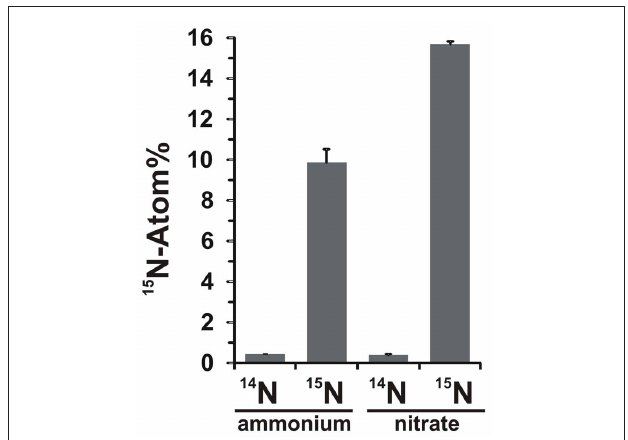
FIGURE 4 | Nitrogen uptake into N. profundicola biomass determined following one round of batch culture with 5mM of the indicated nitrogen compounds supplied at natural abundance ( 14 N) or at 20 Atom% 15 N. Values are averages of 3 independent biological replicates ± the standard deviation.